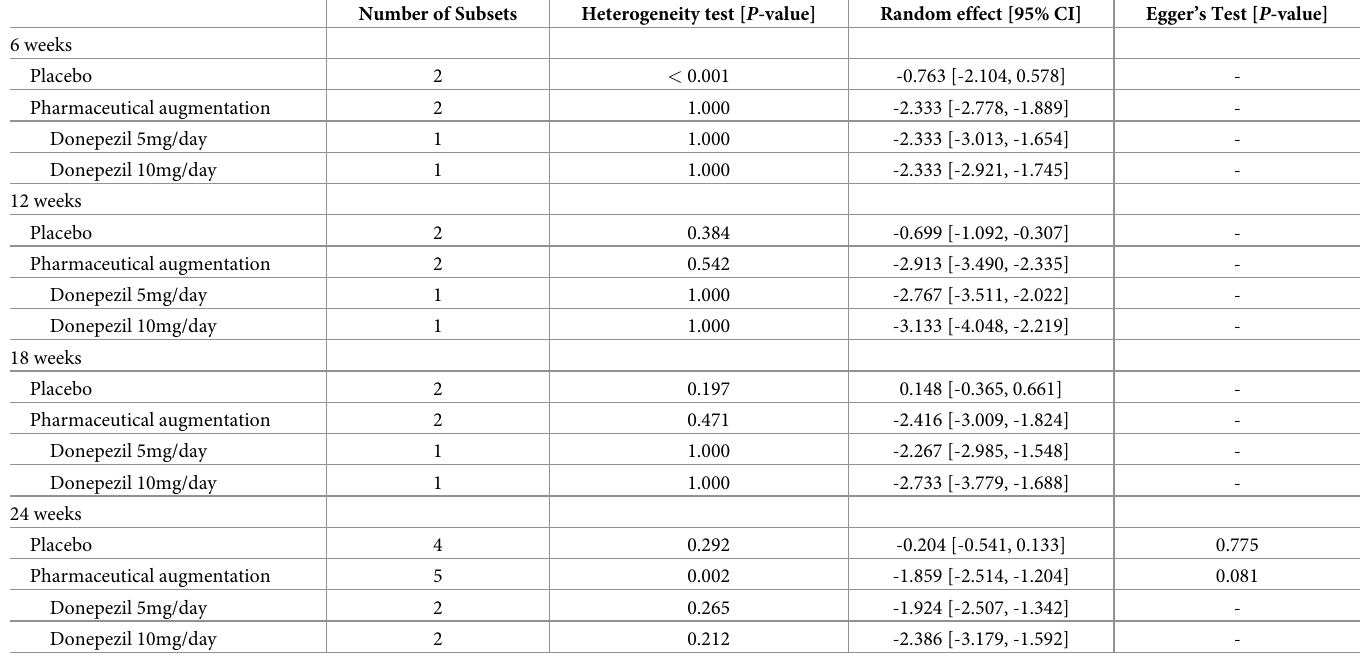
Table 3. The mean difference of ADAS-cog score according to the pharmaceutical augmentation.